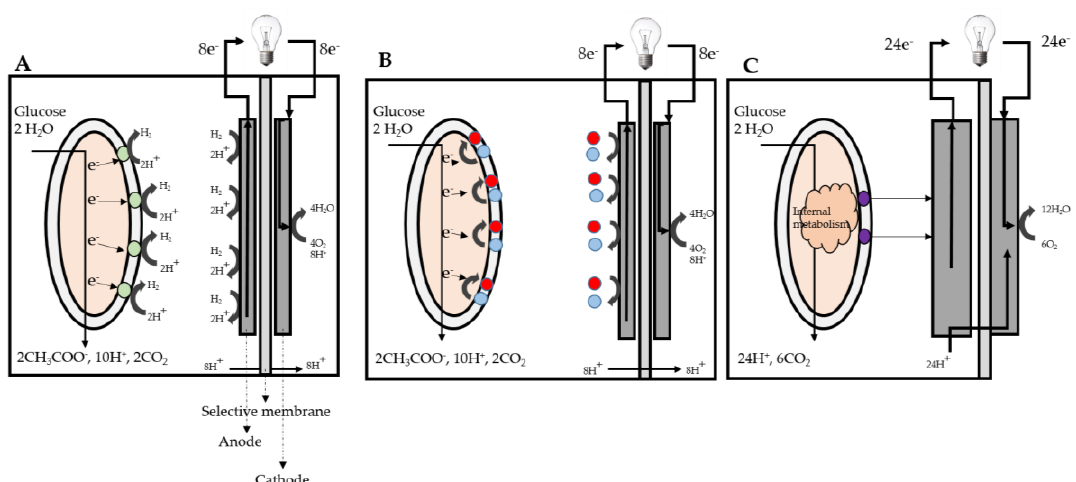
Figure 3. ( a ) An indirect microbial biofuel cell; ( b ) A mediator-driven microbial biofuel cell; ( c ) A direct electron transfer microbial biofuel cell.